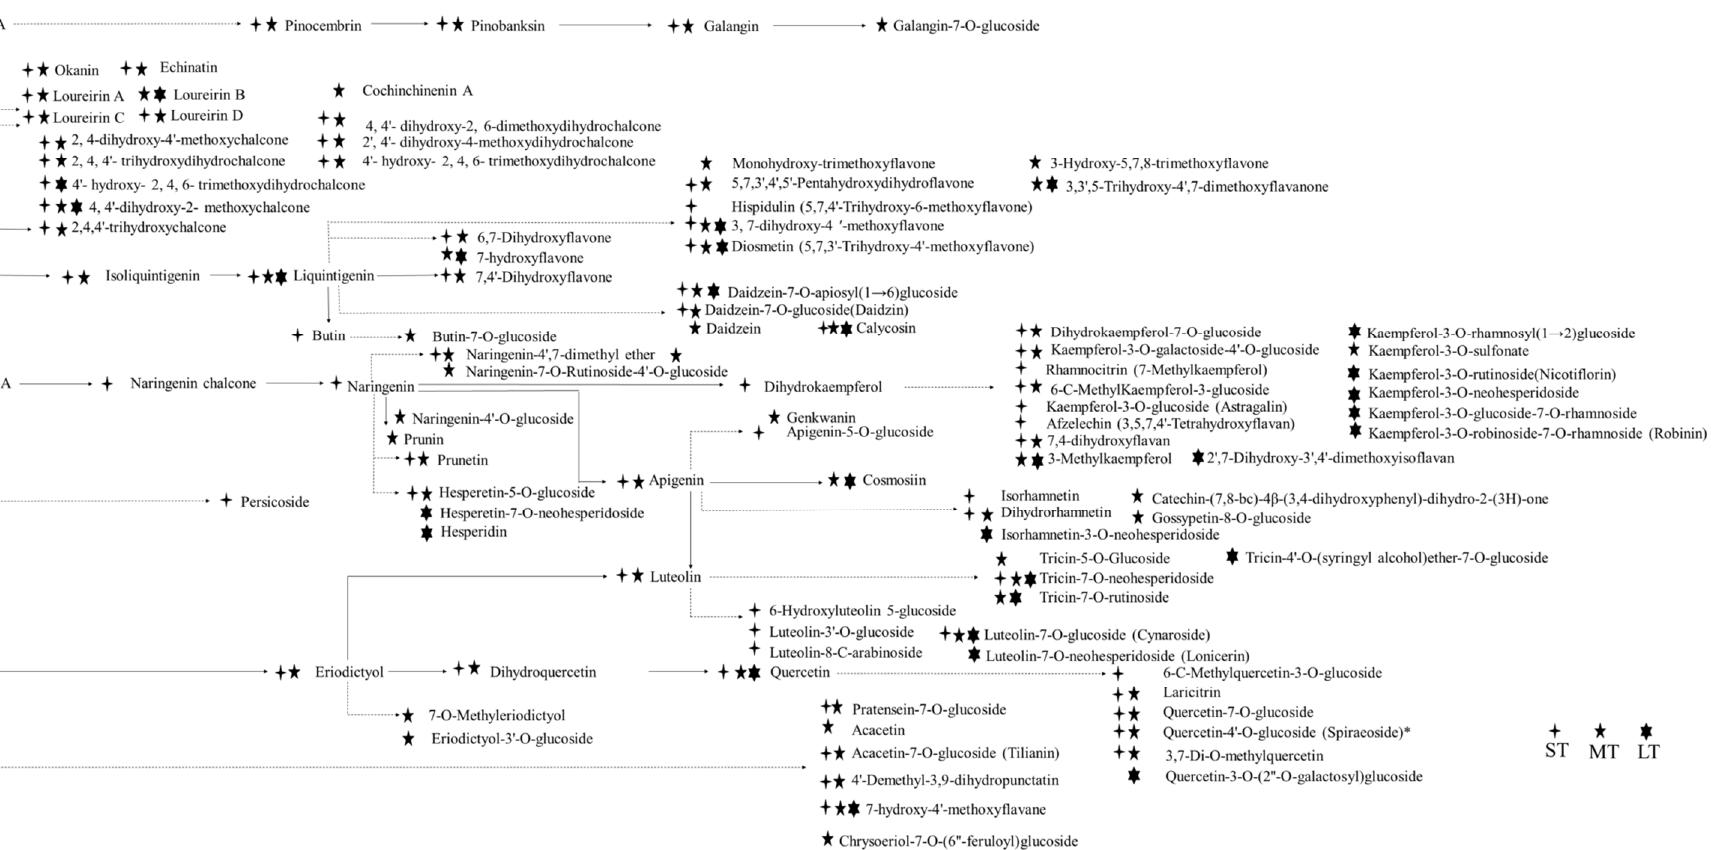
Figure 5. Flavonoid biosynthesis profile at chemical level in D. cochinchinensis after wounding. ST, short term; MT, middle term; LT, long term.